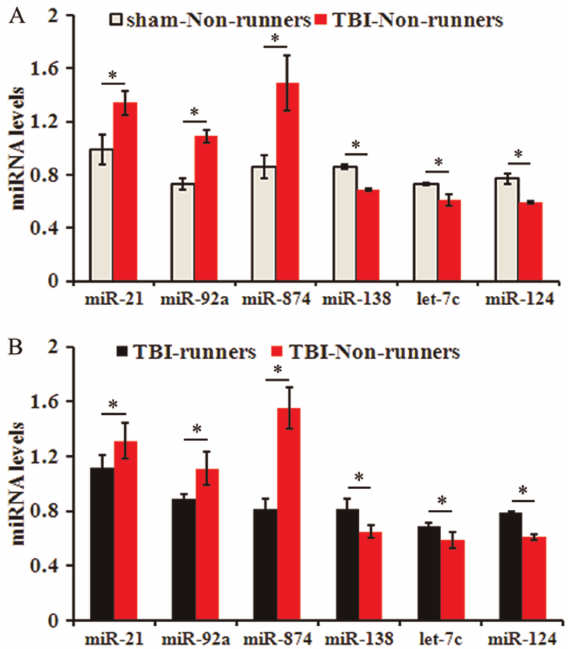
Figure 5. Expressions of miRNA detected by quantitative RT- PCR. Expression levels of miR-21, miR-92a, miR-874, miR-138, let-7c and miR-124 in sham-non-runners and traumatic brain injury (TBI)-non-runners ( A ) or in TBI-non-runners and TBI- runners group ( B ). Data are reported as means±SE. *P , 0.05 (Student’s t